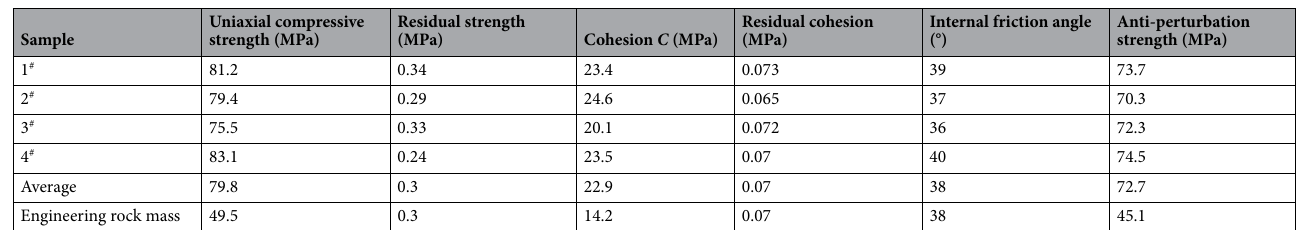
Table 1. On-site monitoring results of impacting energy caused by basic roof break of the 3301 working face.